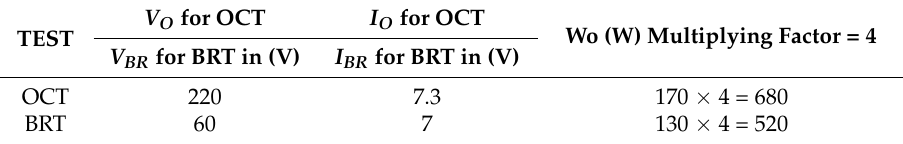
Table 5. Testing of the single-phase induction machine (IM).